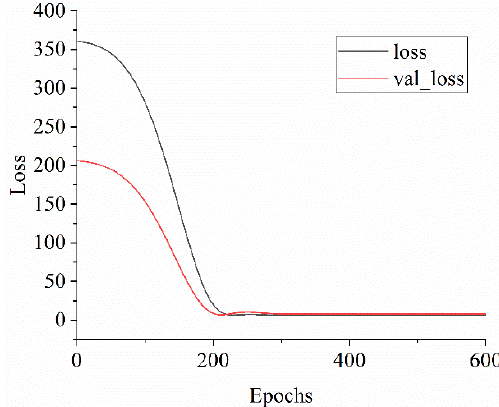
Figure 7. Loss curves of BP-ANN: variation in training loss and validation loss with epochs.